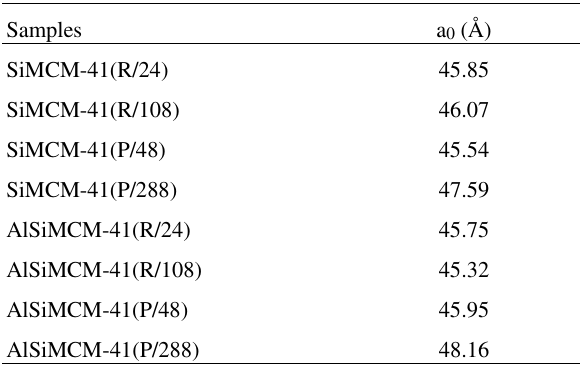
Table 2. Parameter a 0 for SiMCM-41 and AlSiMCM-41